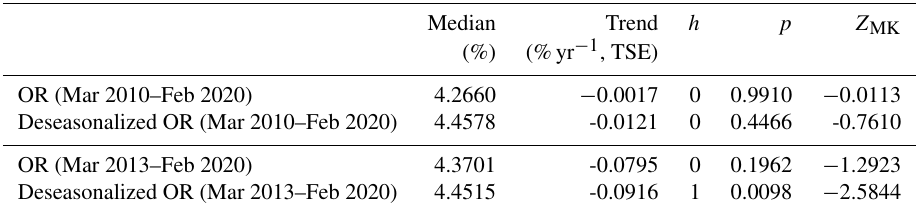
Table 3. Long-term trends of monthly occurrence rate (OR) of cirrus clouds at the typical cirrus altitude range from 6 to 13km derived from both day- and night-time data during the period from March 2010 to February 2020 with the Theil–Sen estimator (TSE) method including the Mann–Kendall (MK) significance test.